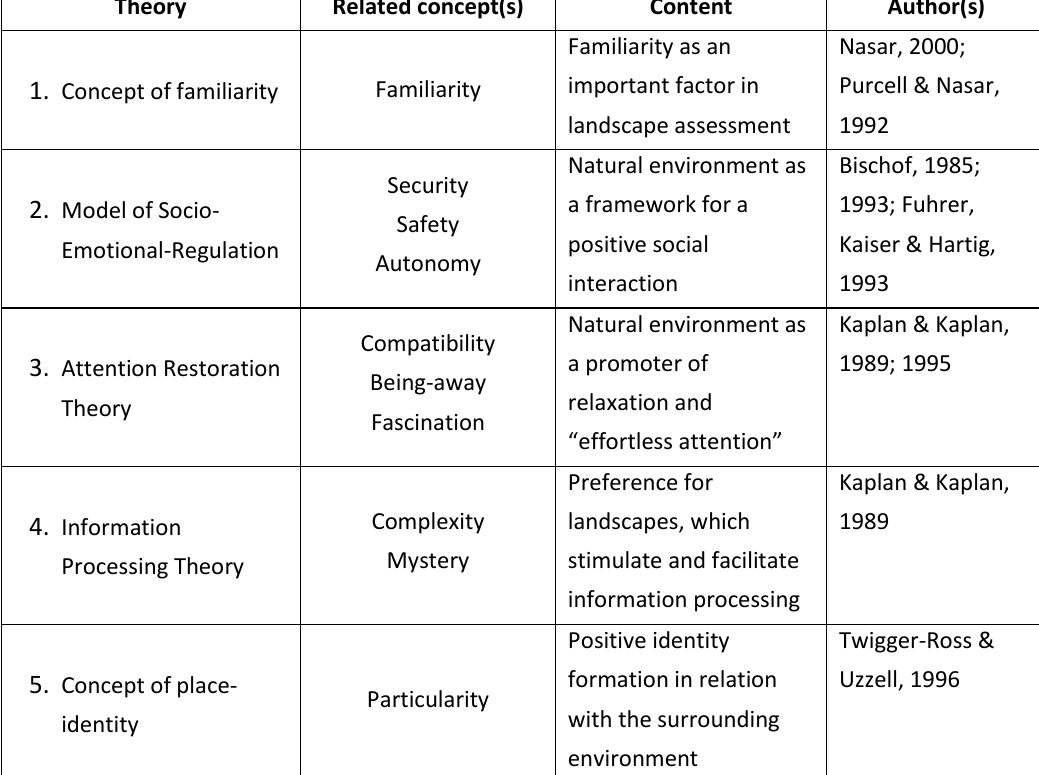
Table 1: Overview of the five theoretical approaches used for our suggested